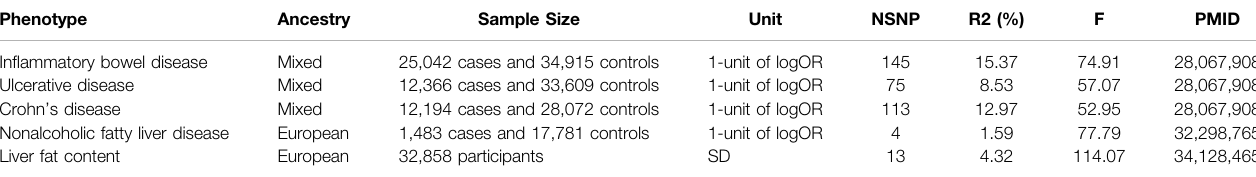
TABLE 1 | A brief description of each GWAS summary statistics.